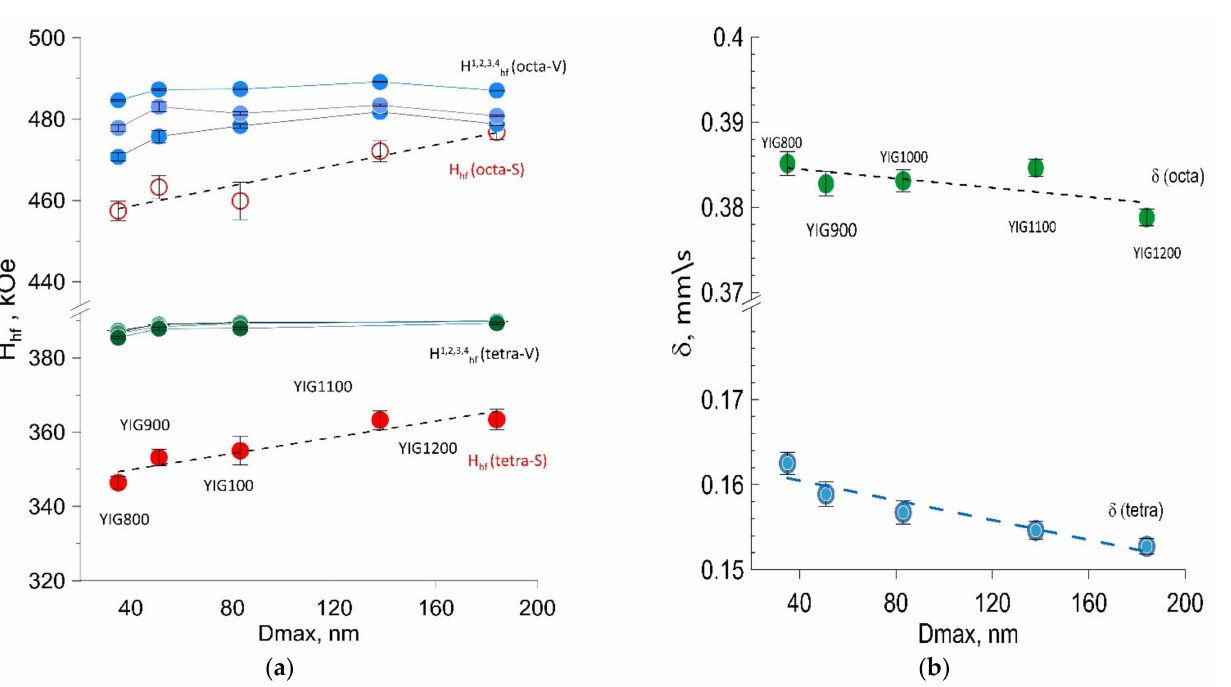
Figure 5. Hyperfine magnetic fields (H hf ) ( a ) and isomer shift ( δ ) ( b ) dependences on particle size.